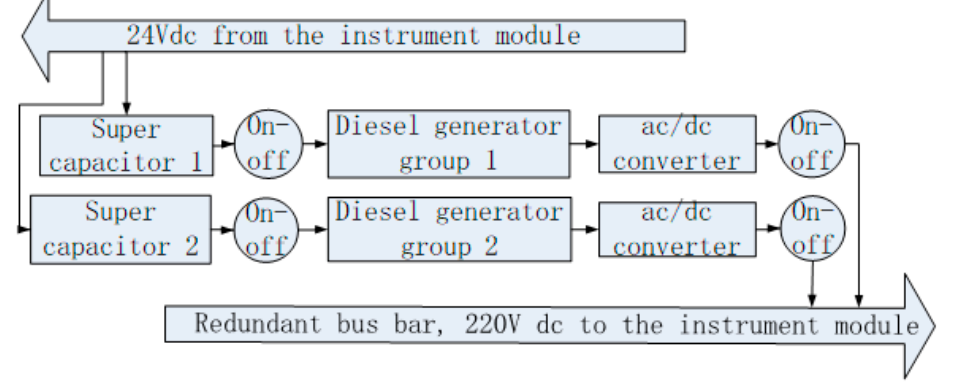
Figure 2. Diesel generator power system structure.